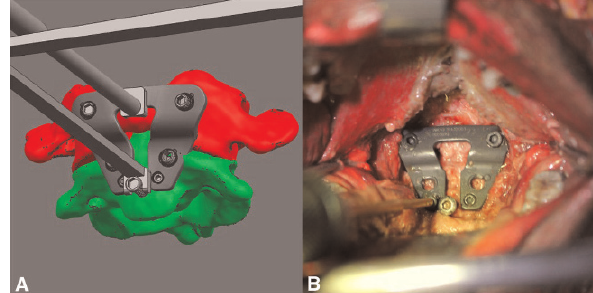
Figure 7 - A diagram showing the comparison between the digital and realistic final reduction positions. A The relationship between the reduction screw and the lower border of the TARP- IV in the planning phase. B The relationship between the reduction screw and the lower border of the TARP-IV in the cadaveric experiment. Note the lower border of the TARP-IV was aligned with the center of the reduction screw head in both